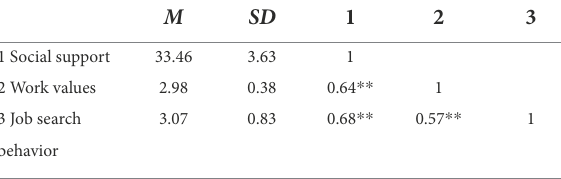
TABLE 1 Descriptive statistics and correlations between variables ( n =